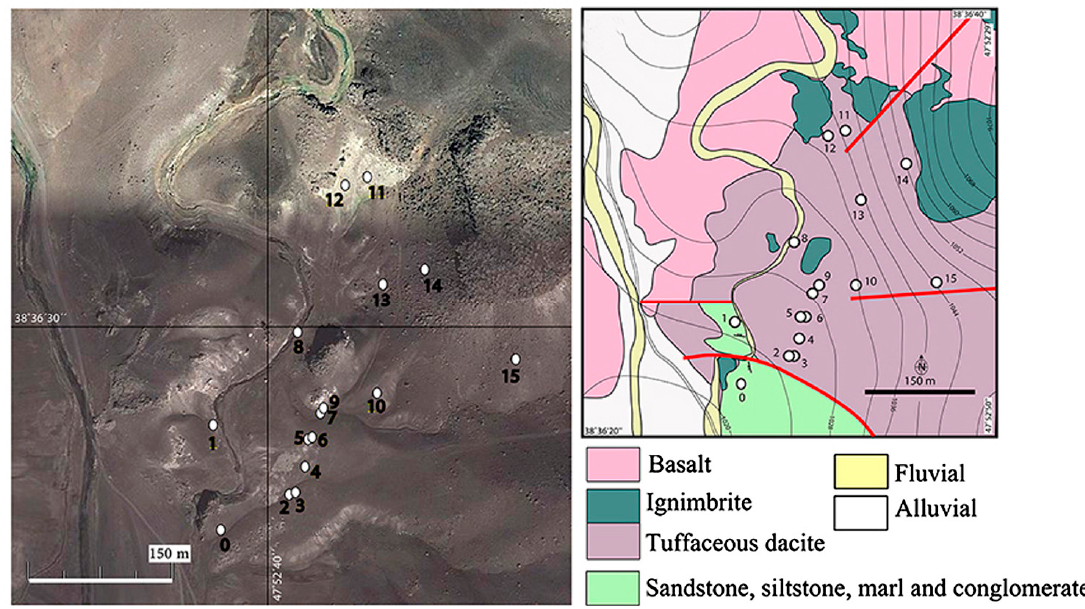
Figure 4. Geographic distribution of fossil logs. ( Left ) Satellite map; ( Right ) geologic map. Faults are shown by red